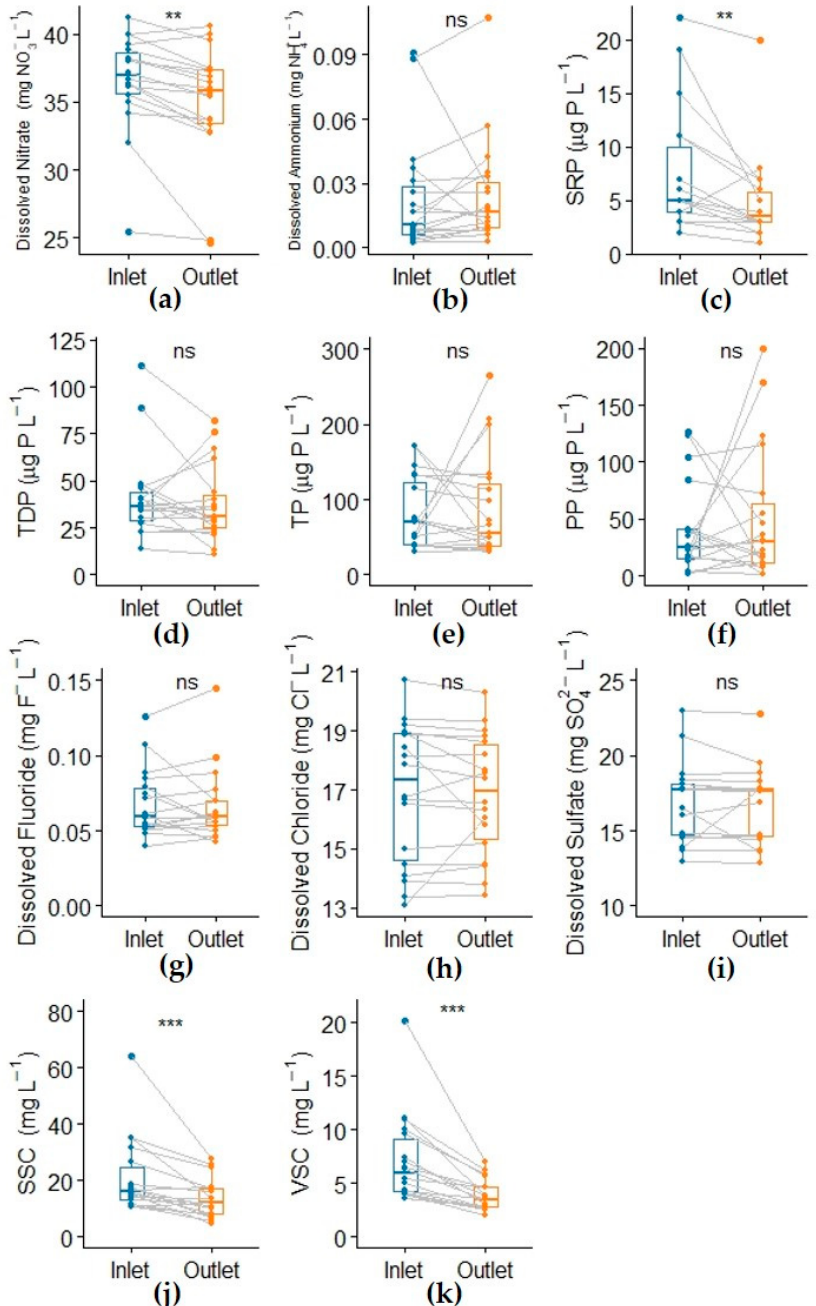
Figure 3. Boxplots showing paired on-line pond inlet and outlet concentrations for ( a ) dissolved nitrate; ( b ) dissolved ammonium; ( c ) SRP; ( d ) TDP; ( e ) TP; ( f ) PP; ( g ) dissolved fluoride; ( h ) dissolved chloride; ( i ) dissolved sulfate; ( j ) SSC and ( k ) VSC. Median values are represented by bold lines. Significance levels for results of paired samples t -tests are indicated with: *** ( p < 0.001), ** ( p < 0.01), ns ( p > 0.05).